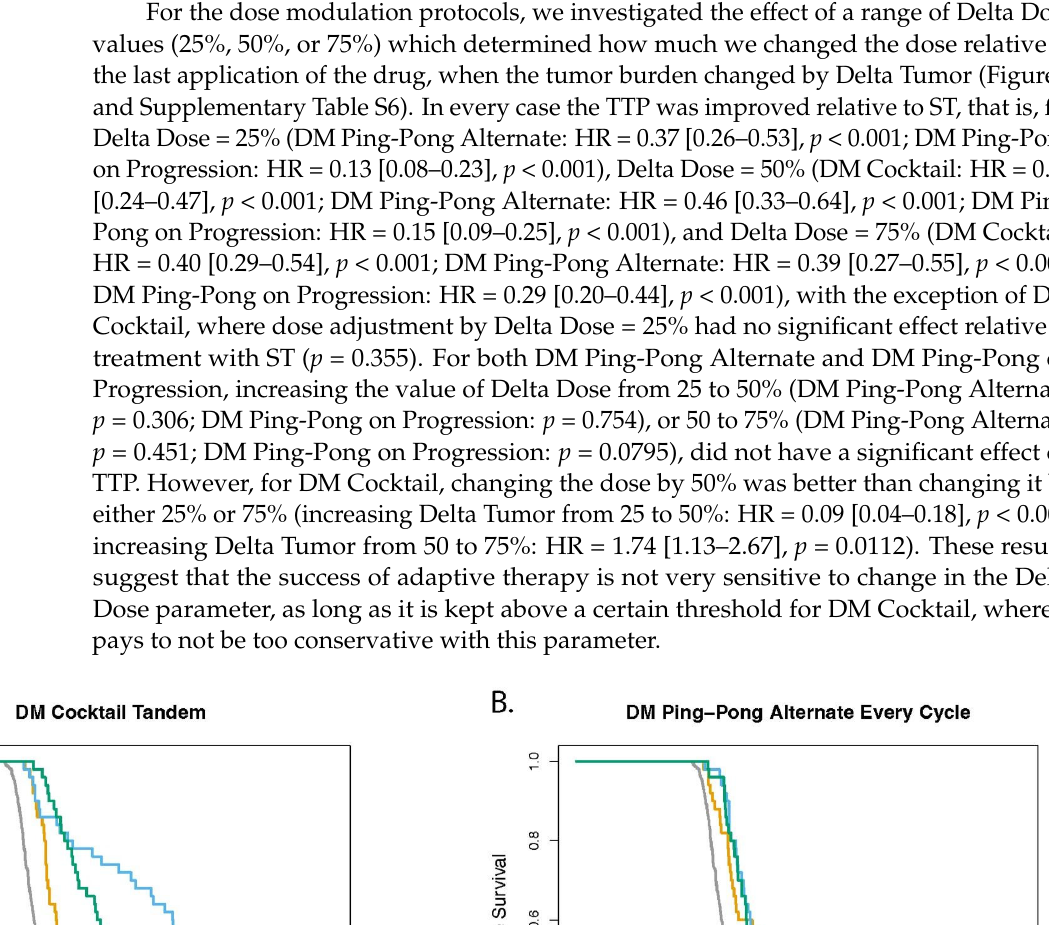
Figure 9. Role of the Delta Dose parameter for dose modulation (DM) adaptive therapy protocols. The panels show the comparison of adaptive therapy (AT) versus standard treatment (ST) as the